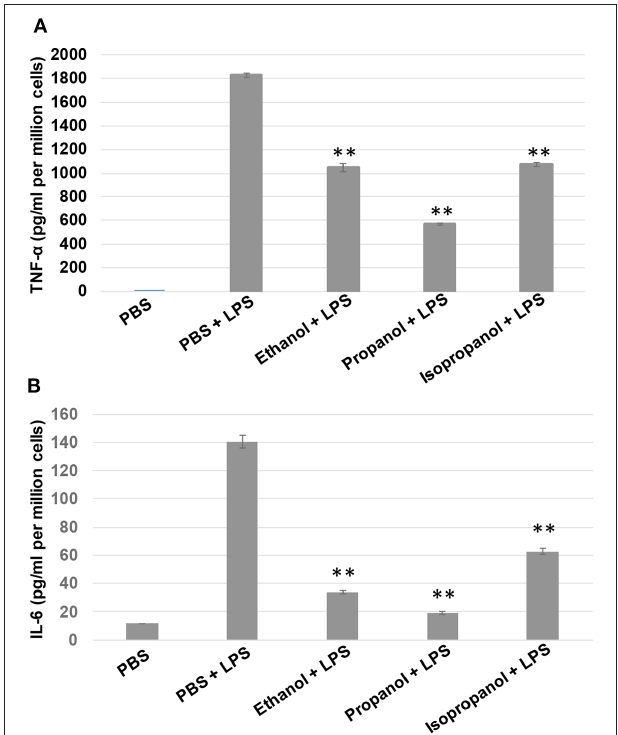
FIGURE 2 | Short-chain alcohols reduce LPS-stimulated TNF- α and IL-6 production by MM6 cells. MM6 cells (1 × 10 6 ) were exposed to 50mM ethanol, propanol, or isopropanol for 24 hours. LPS exposure (1 µ g/ml) was added 1h after the addition of alcohol. A PBS control group of MM6 cells was similarly set and stimulated. Culture media were collected. TNF- α (A) and IL-6 (B) levels were measured by ELISA, and are expressed here as picogram per milliliter per million cells. Asterisks denote statistically significant difference by student’s t -test ( p < 0.01, n = 4 per